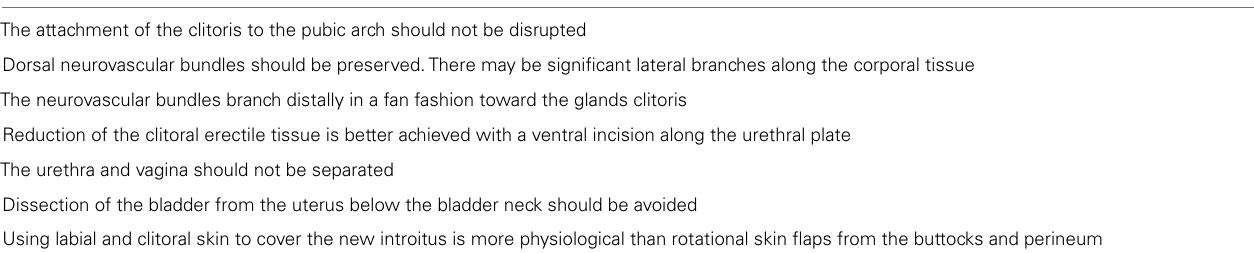
Table 1 | Current surgical recommendations on feminizing genitoplasty and clitoral surgery . The attachment of the clitoris to the pubic arch should not be disrupted Dorsal neurovascular bundles should be preserved.There may be significant lateral branches along the corporal tissue The neurovascular bundles branch distally in a fan fashion toward the glands clitoris Reduction of the clitoral erectile tissue is better achieved with a ventral incision along the urethral plate The urethra and vagina should not be separated Dissection of the bladder from the uterus below the bladder neck should be avoided Using labial and clitoral skin to cover the new introitus is more physiological than rotational skin flaps from the buttocks and